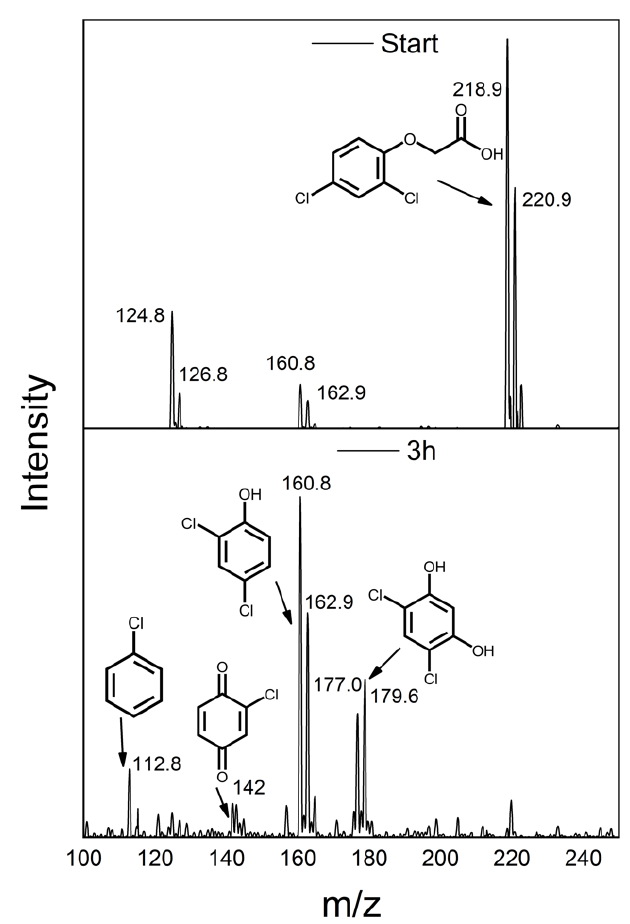
Figure 7. ISI-MS spectra acquired during the photocatalytic tests using the TiO 2 -rGO solar sample. In the upper panel the spectrum before the photocatalytic experiment, in the bottom after 3 h irradiation.